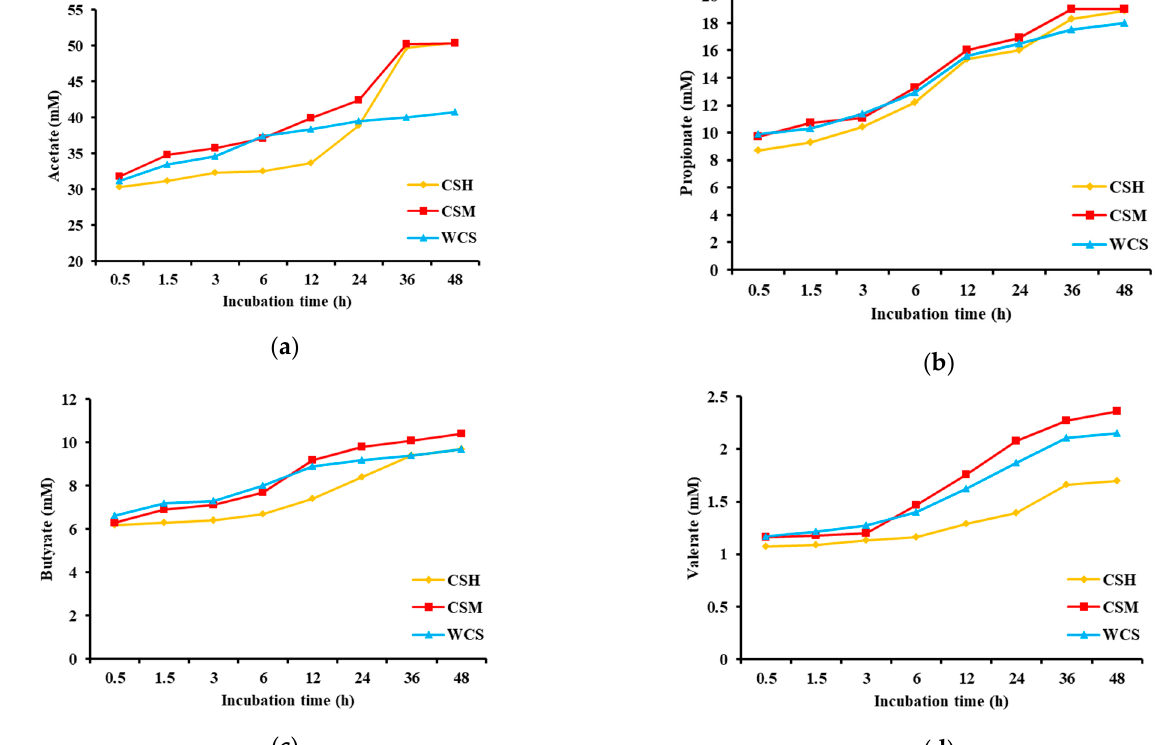
Figure 3. Rumen microbial fermentation characteristics of three kinds of samples: ( a ) acetate, ( b ) pro- pionate, ( c ) butyrate, ( d ) valerate, ( e ) BCVFA, ( f ) NGR, and ( g ) FE. ( h ) Correlation analysis of tVFA and FG. BCVFA, branched volatile fatty acids; FE, fermentation efficiency; FG, free gossypol; NGR, the ratio of non-glucogenic to glucogenic acid; tVFA, total volatile fatty acid. The average total VFA concentrations of CSH, CSM, and WCS reached 87.7,